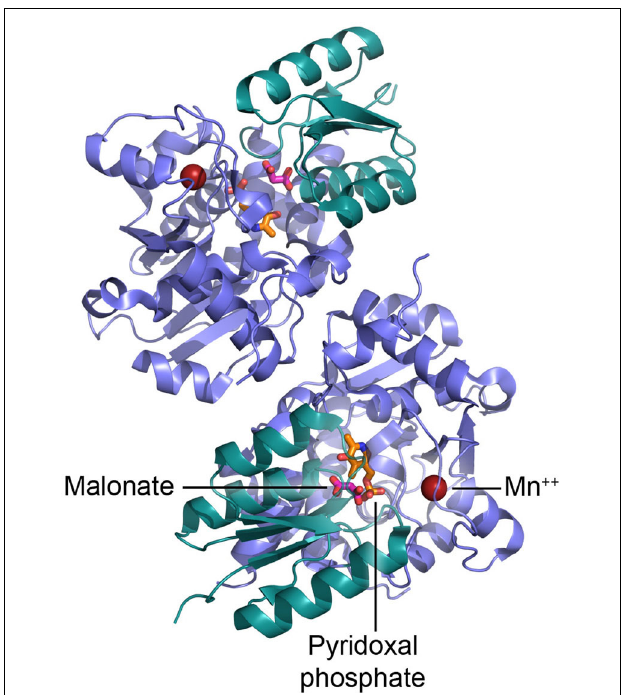
FIGURE 3 | Dimeric structure of human SR and details of the active site. PLP is shown in orange, malonate in red, and Mn 2 + as red sphere.